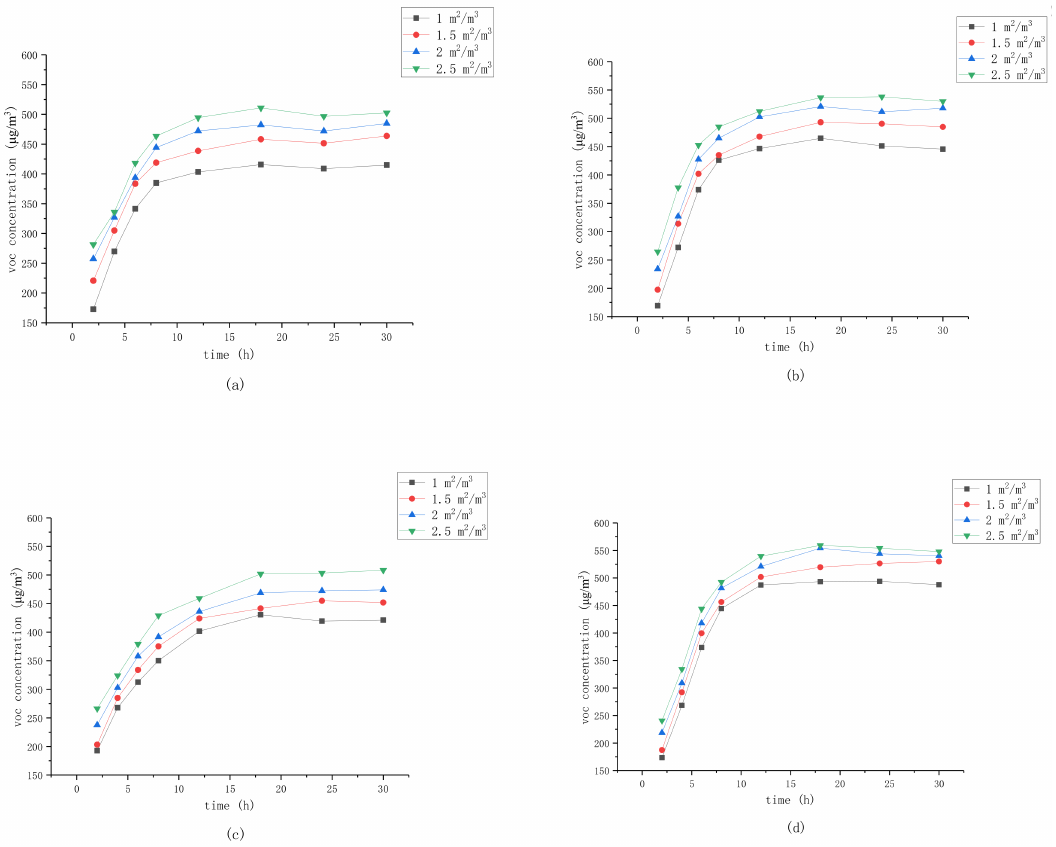
Figure 2. Trend of VOCs with airtight time under di ff erent loading ratios: PVC-P ( a ), MI-P ( b ), UF-P ( c ) and WP-P ( d